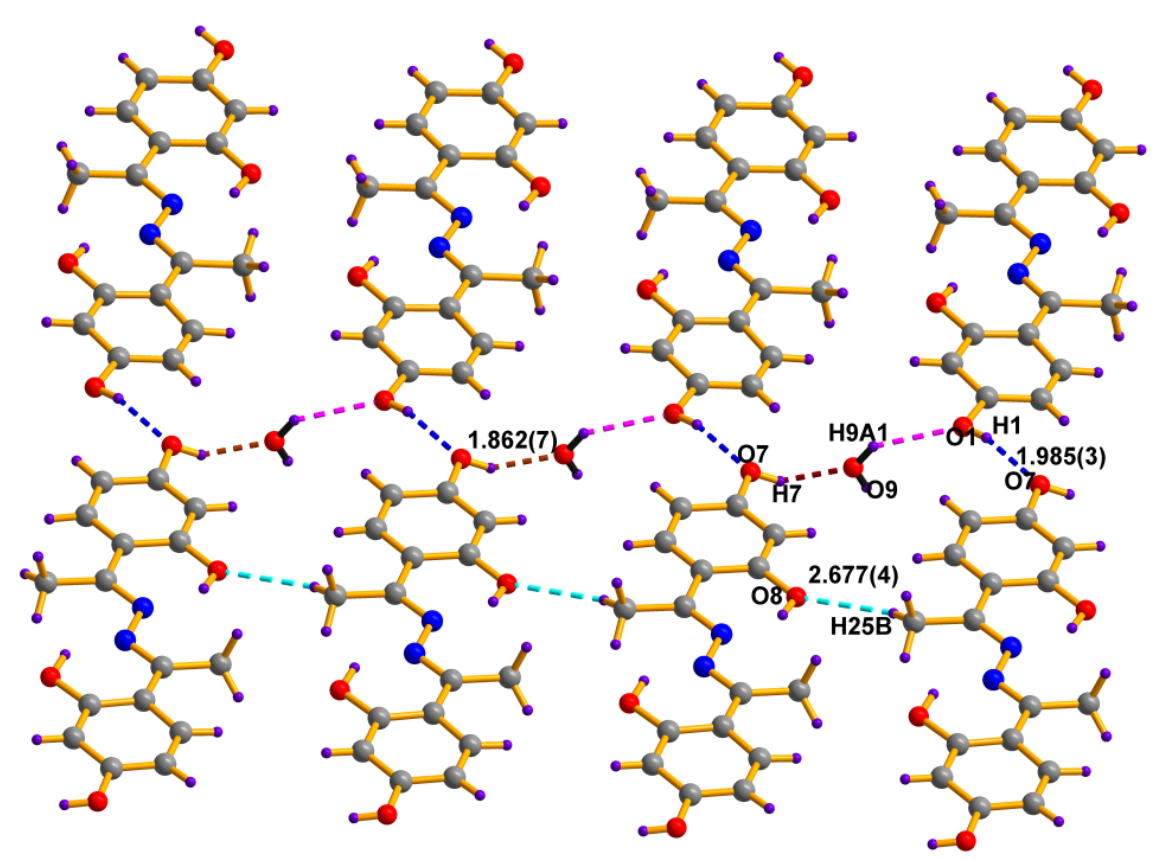
Figure 3. Packing diagram of compound 2 having two different molecules in the asymmetric unit.